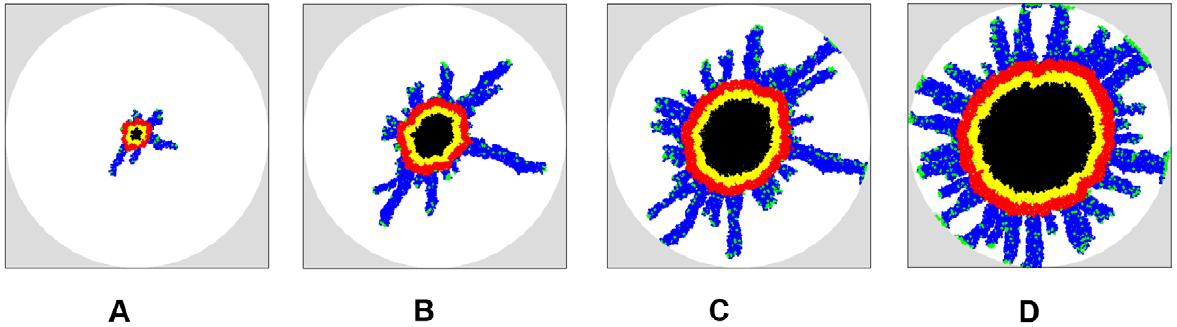
Figure 9. Evolution of simulated tumor in random ECM. The mutation rate is c ~ 0 : 05 , the cell motility is m ~ 3 and ECM degradation ability is x ~ 0 : 9 . (a) Growing tumor on day 50. (b) Growing tumor on day 80. (c) Growing tumor on day 100. (d) Growing tumor on day 120. Note that both the primary tumor and invasive pattern are affected (i.e., becoming anisotropic) by the ECM heterogeniety in the early growth stages. Also note that unlike the case in Figure 6(d), the invasive cells clump at the tips of invasive branches since they have reached the boundary of the growth-permitting region. Although we only consider spherical growth-permitting regions here, our tumor-growth simulations can incorporate growth-permitting regions with arbitrary shapes.